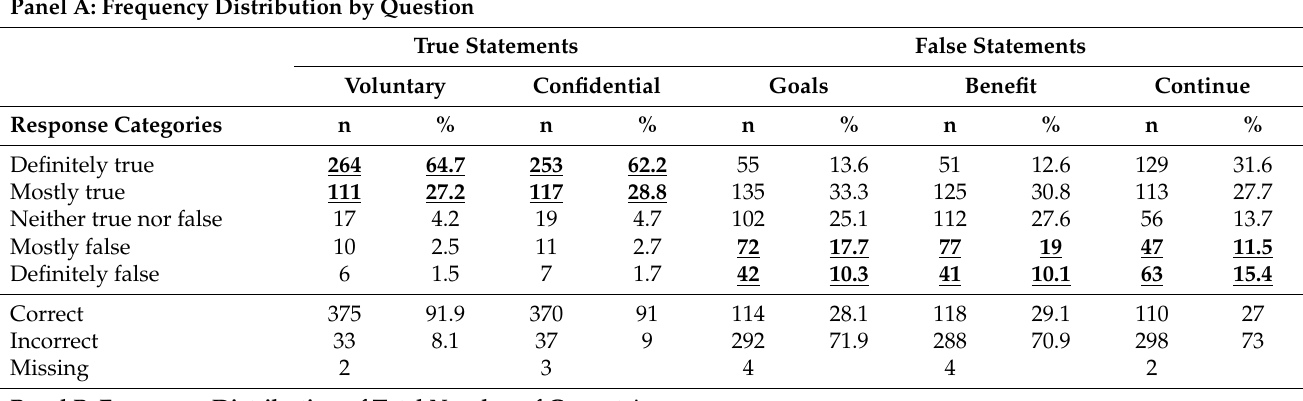
Table 3. Frequency Distribution of Answers to MRL